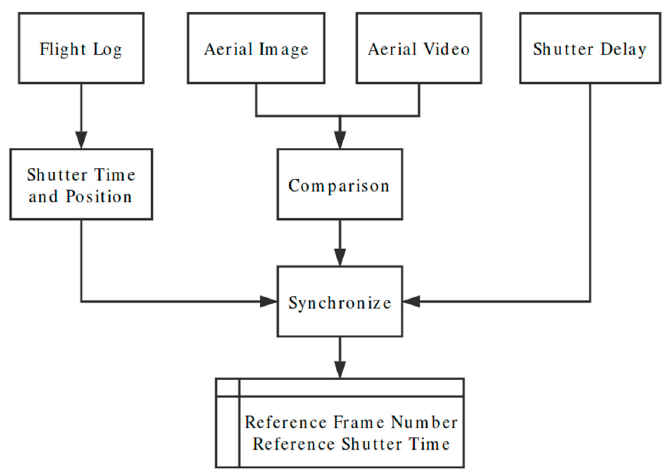
Figure 13 . Flowchart for the synchronization of the aerial video and the flight data log.